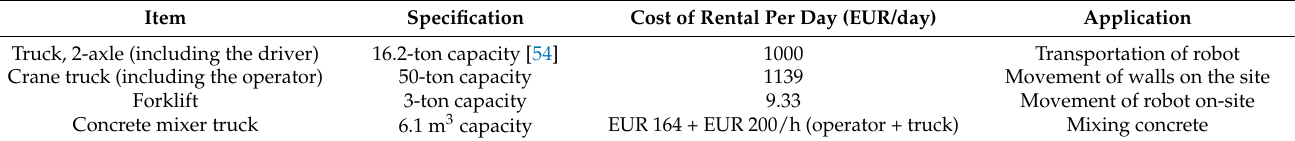
Table 4. Required equipment for